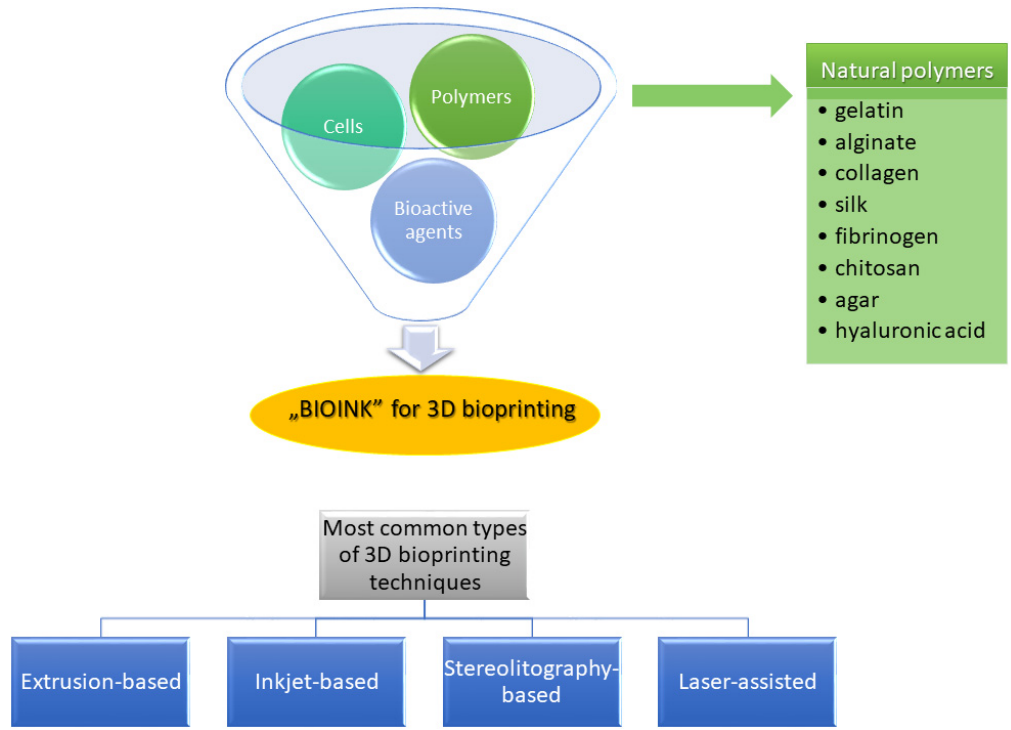
Figure 5. Summary of 3D bioprinting technology: examples of natural polymers used for a fabrication of “bioinks” and the most common types of bioprinting techniques [160,161].